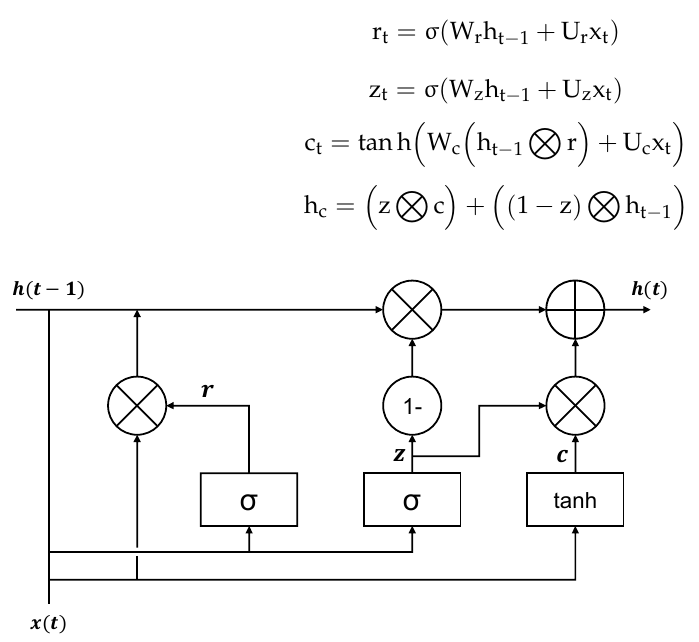
Figure 2. Gated recurrent unit (GRU) cell architecture.